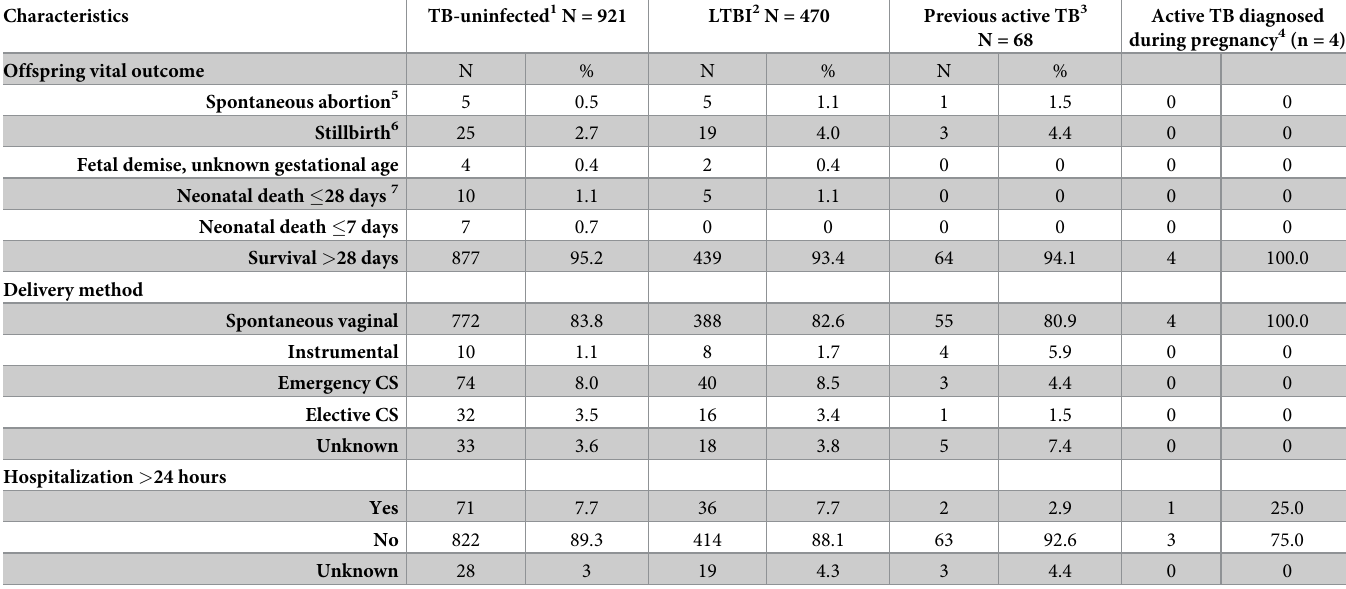
Table 2. Pregnancy outcomes with regard to TB infection category.